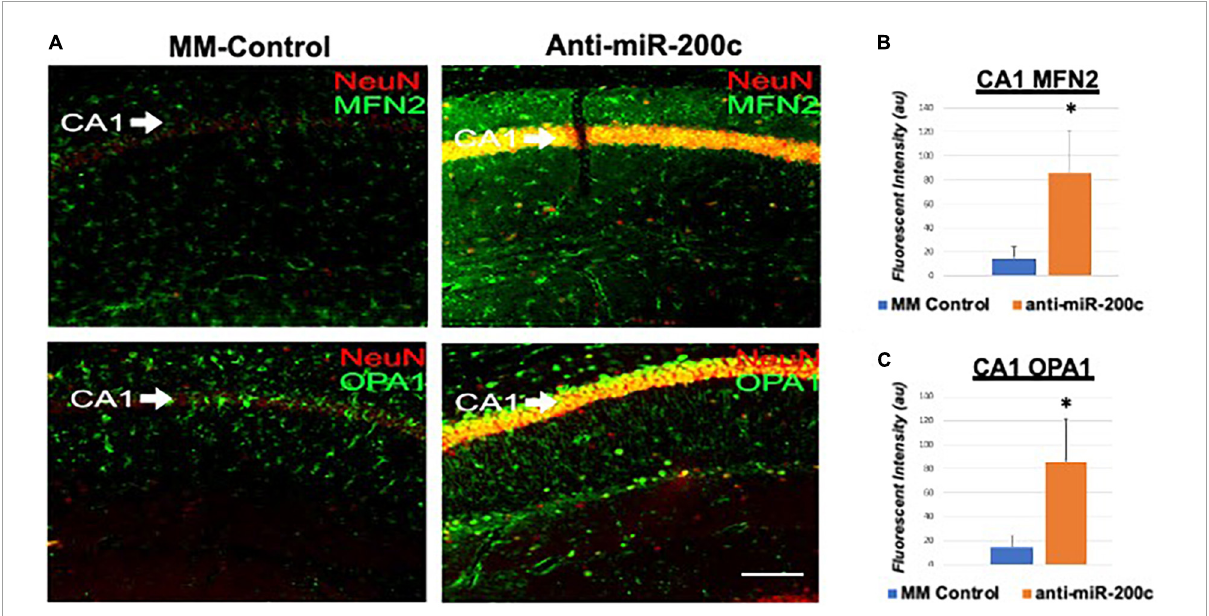
FIGURE3 Mitofusin-2 (MFN2) and OPA1 expression in CA1 after global cerebral ischemia in mice. (A) Representative images of fluorescent IHC labeling of hippocampal NeuN (red) and MFN2 or OPA1 expression (green) 7 days after global cerebral ischemia with and without IV anti-miR-200c post-treatment. Quantification of MFN2 (B) and OPA1 (C) in all cells within CA1. N = 5–8 animals per treatment group, mean + SEM, * p < 0.05. Scale bar, 25 µ m.